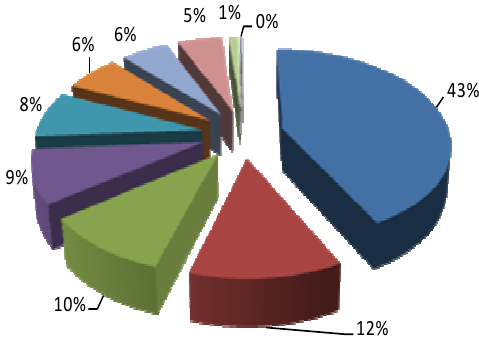
Fig. 3. Geoelement spectrum